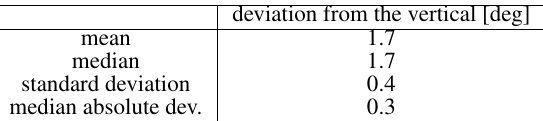
Table 3. Deviation from the vertical.